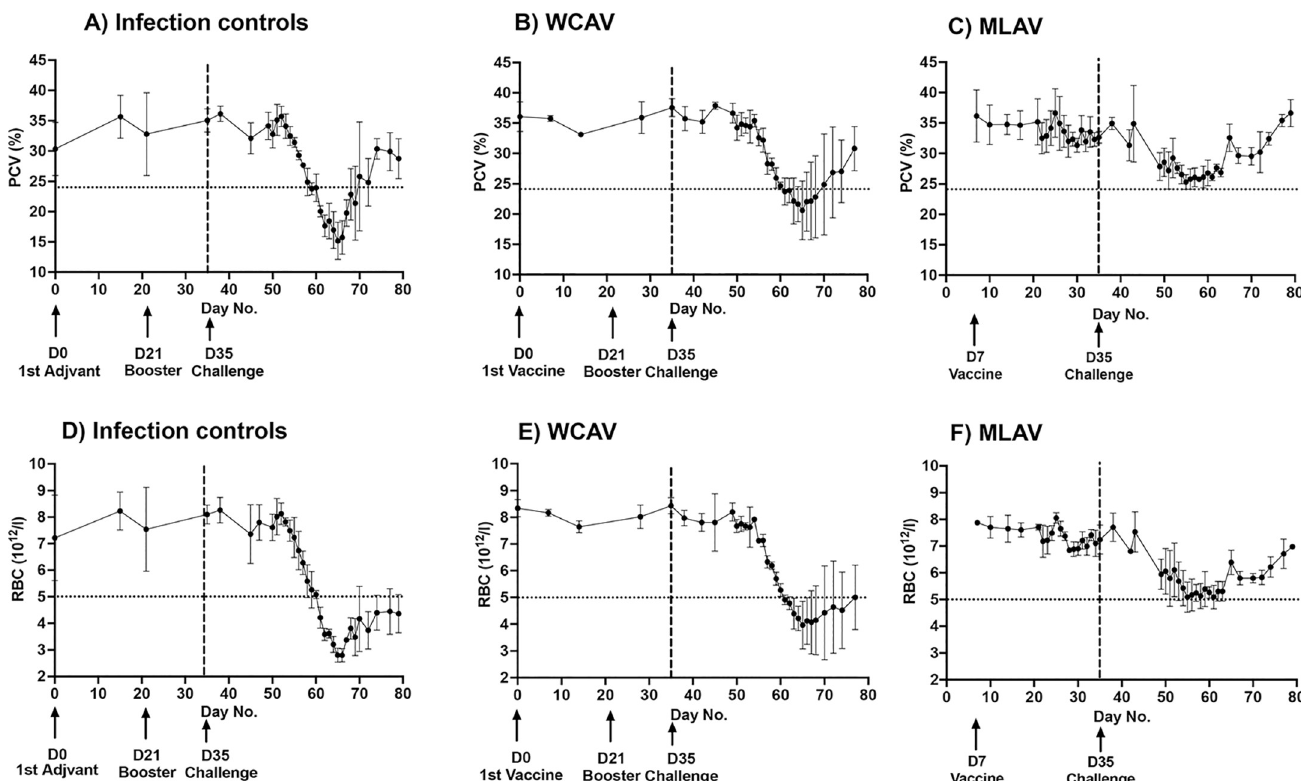
Fig 3. PCV and RBC count assessed in all three groups of steers. Average PCV and RBC values from animals sampled during the study period were presented for the non-vaccinated animals, WCAV and MLAV during vaccination phase and following infection challenge. Days of adjuvant injections (control group), vaccinations (WCAV and MLAV) and infection challenge day (all three groups) are identified in the figures. At significance level α = 0.05, One-way ANOVA with repeated measures showed significant differences for PCV (P = 0.0128 � ) and RBC (P = 0.0375 � ) levels for MLAV compared to infection controls or WCAV group animals for the days 60–70. However, no significant difference was observed for WCAV and infection control groups throughout the study period. Tukey’s multiple comparisons test also showed similar significant differences in PCV (P = 0.0056 �� ) and RBC P = 0.0294 � ) for MLAV group animals compared to infection controls or WCAV animals between days 60 and 70. This method also did not yield significant difference between infection controls and WCAV